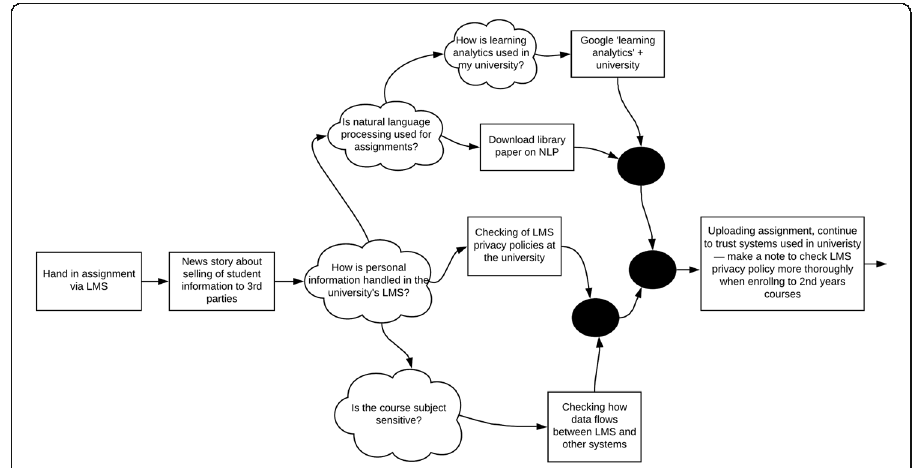
Fig. 7 Context graph of an event in a university